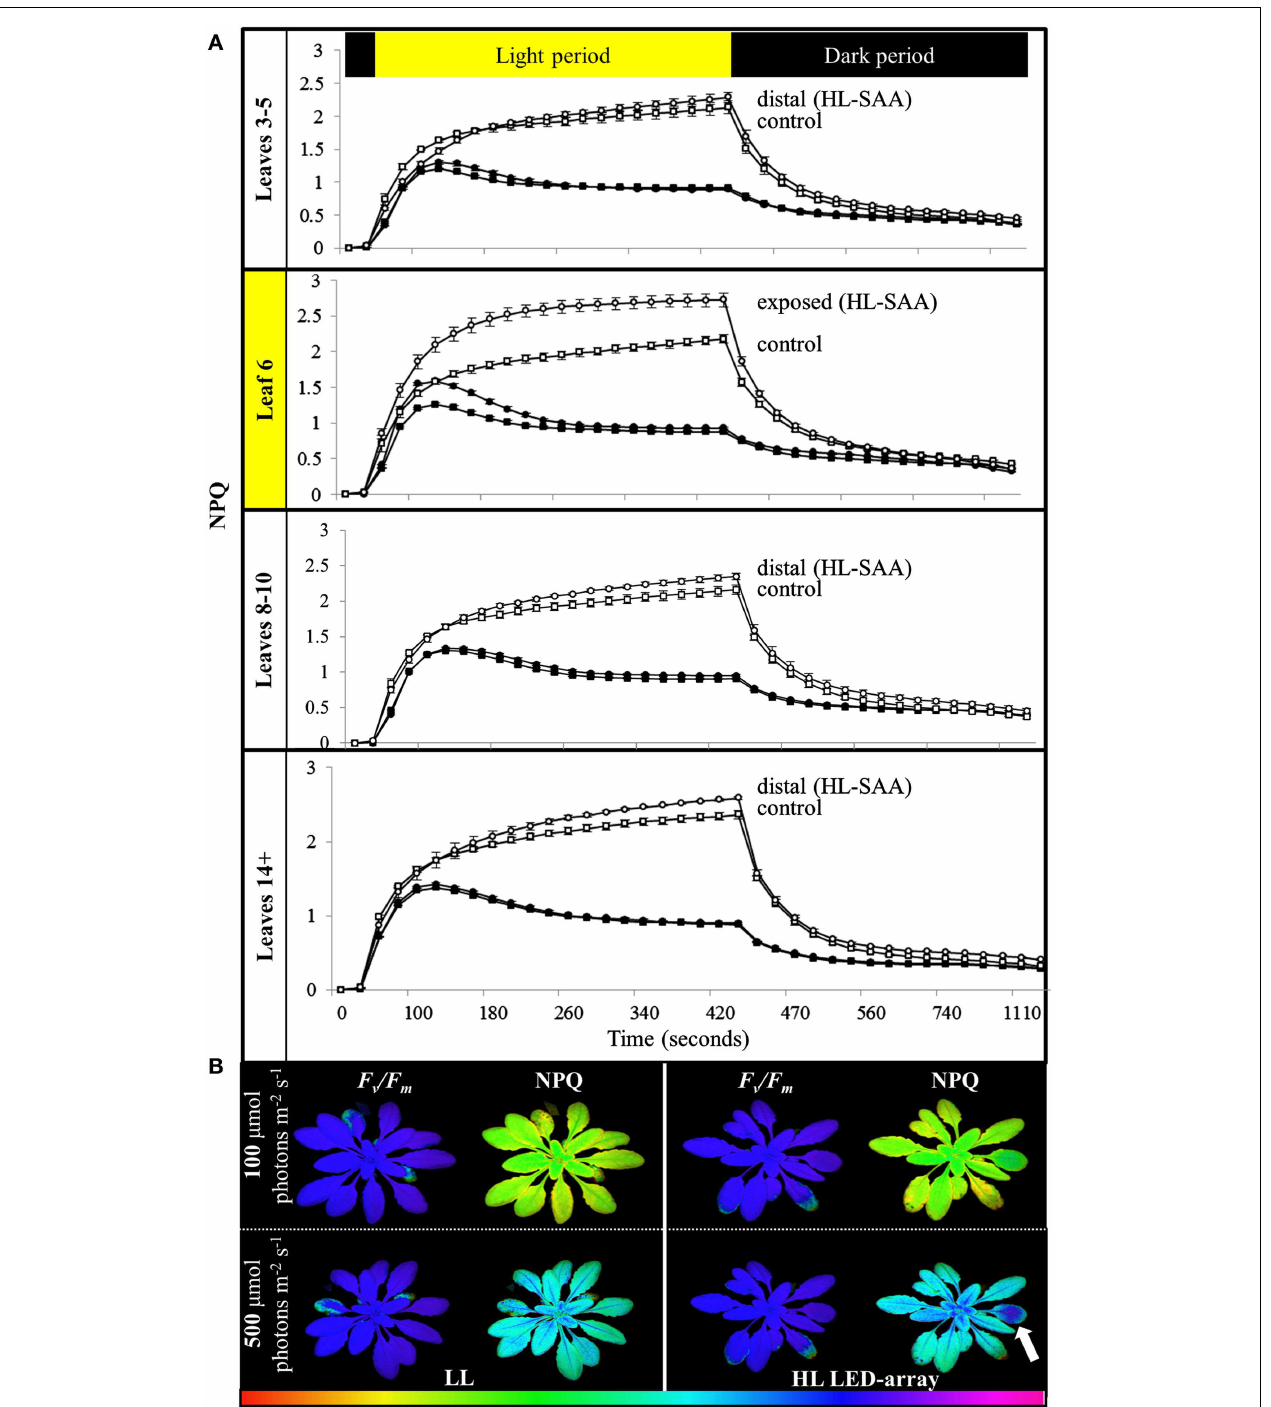
experiment was performed in triplicate, one representative is shown for which n = 3. (B) A representative false color image of NPQ (measured at 420s) from HL LED-array exposed (HL) and untreated (LL) plants under 100 and 500 µ molphotonsm − 2 s − 1 .The colored scale bar represents the corresponding value of NPQ increasing in value from left (red) to right (pink).The circle of dark blue on the treated leaf six is indicated with an